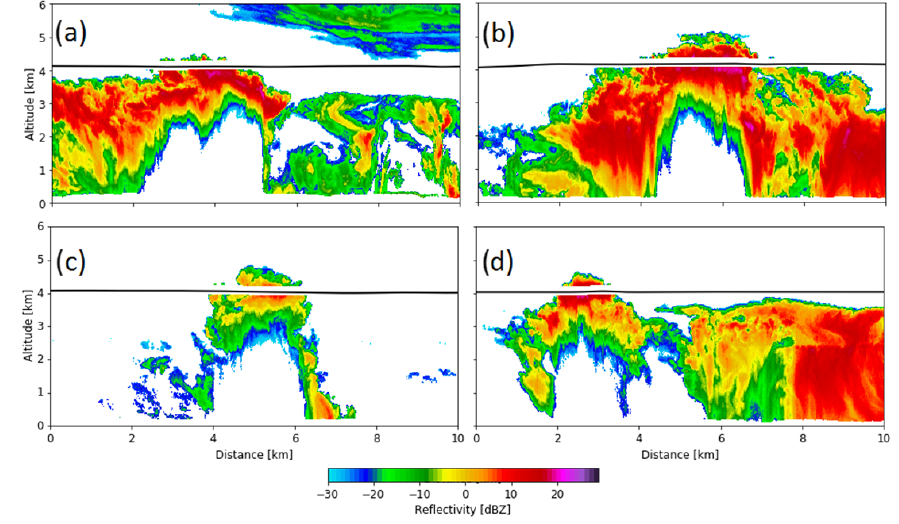
Figure 2. Example images or vertical profile of radar reflectivity from the WCR during penetrations on (a) Case A, (b) Case B, (c) Case C, and (d) Case D at temperatures from − 6 to − 8 ◦